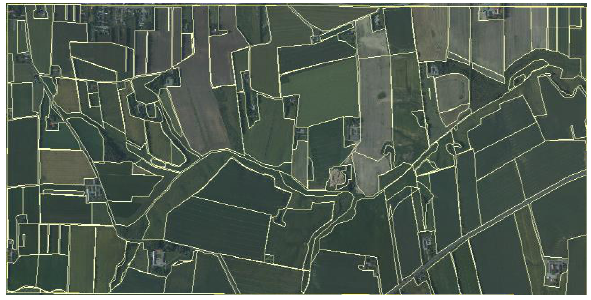
Figure 2. Study area covered by the orthophoto and agricultural